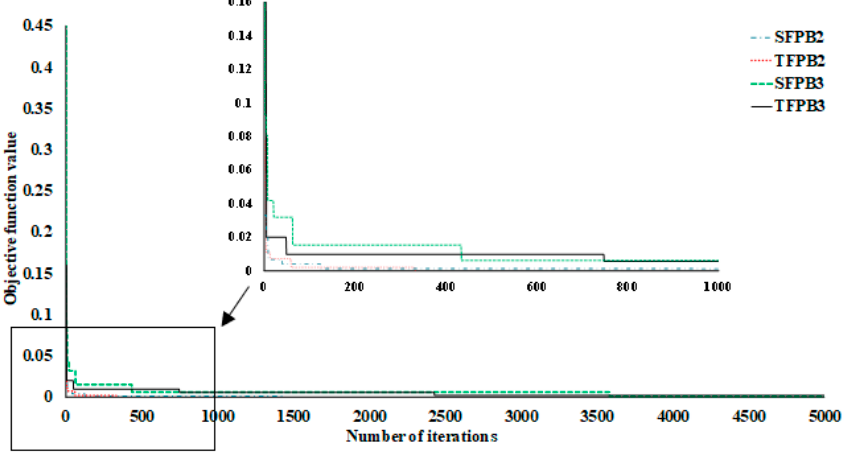
Figure 8. Convergence histories.